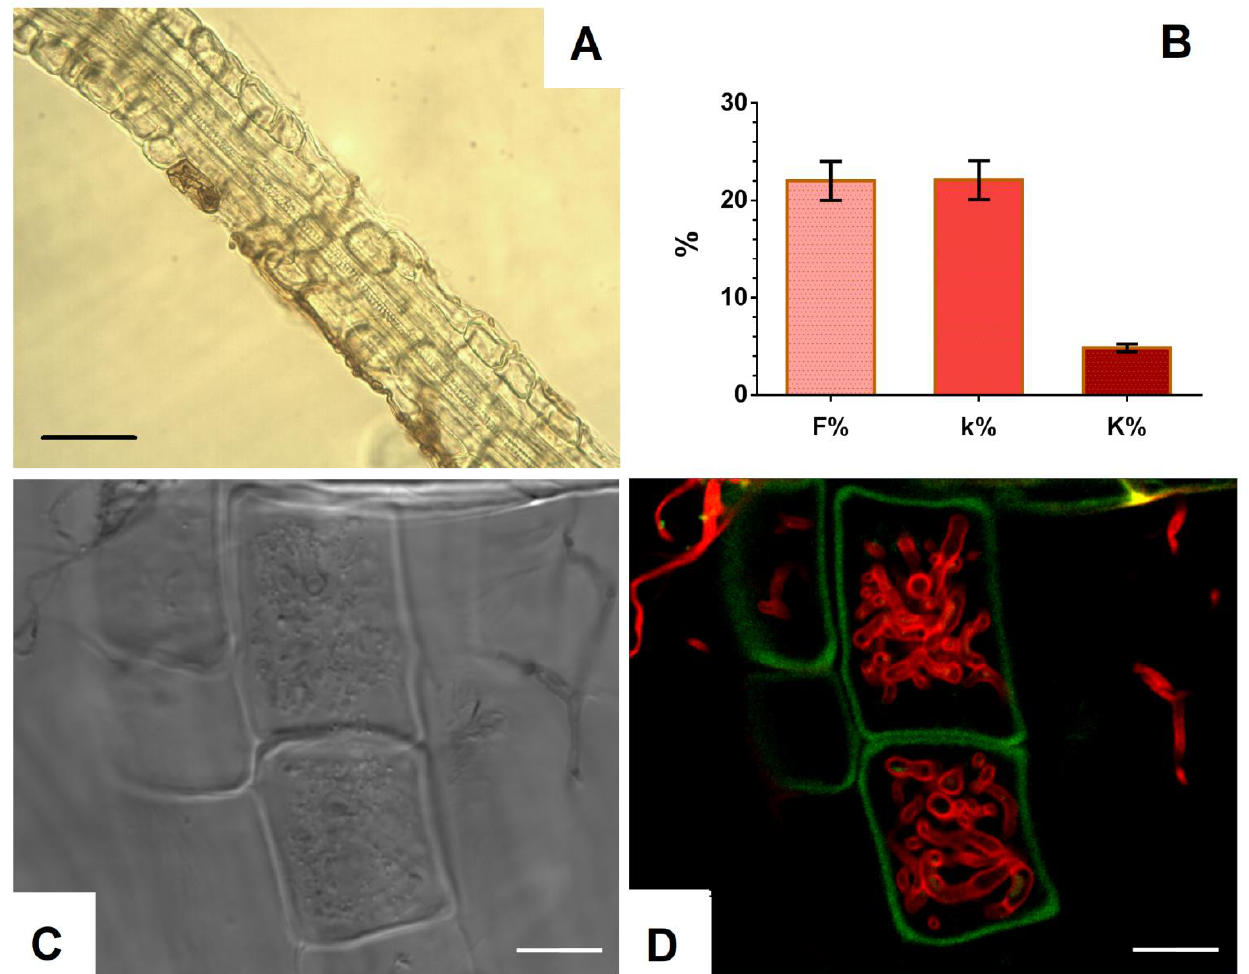
Figure 5. Colonization of V. macrocarpon roots during co-cultivation with P. fortinii DSE2 isolate: ( A ) melanized hyphae of P. fortinii DSE2 isolate in V. macrocarpon root after 5 months of co-cultivation. Bar = 20 µ m; ( B ) indicators of colonization of V. macrocarpon root system after 5 months of co-cultivation: frequency of P. fortinii DSE2 isolate colonization (F%), intensity of P. fortinii DSE2 isolate colonization in DSE-colonized root fragments (k%), and intensity of P. fortinii DSE2 isolate colonization in the root system (K%); ( C ) transmitted light image. Bar = 30 µ m; ( D ) CLSM image of V. macrocarpon root stained with trypan blue. Autofluorescence of root cells (green signal) obtained at λ ex = 488 nm, λ em = 499–540 nm; fluorescence of fungal hyphae stained with trypan blue (red signal) obtained at λ ex = 594 nm, λ em = 620–700 nm. Bar = 20 µ